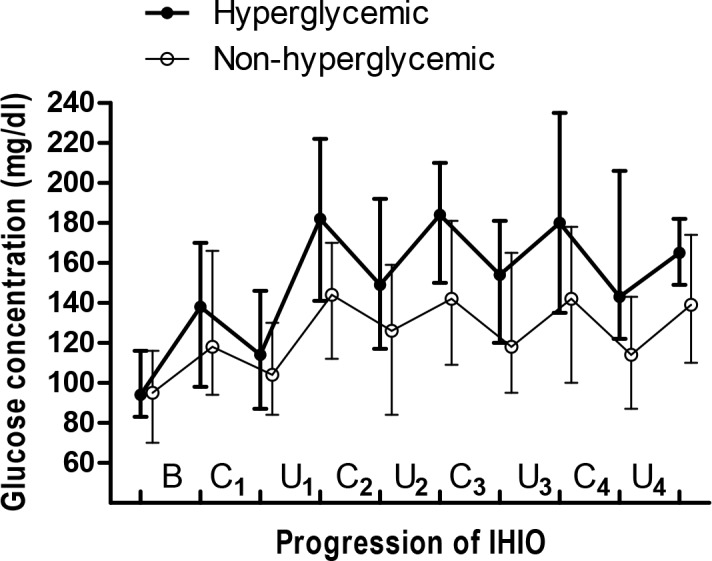
Intraoperative blood glucose concentrations before the start of IHIO (B), during each clamping period (C), and during each unclamping period (U) in donors who developed intraoperative hyperglycemia and in donors without intraoperative hyperglycemia.Circlet indicates the median and whiskers indicate the range.